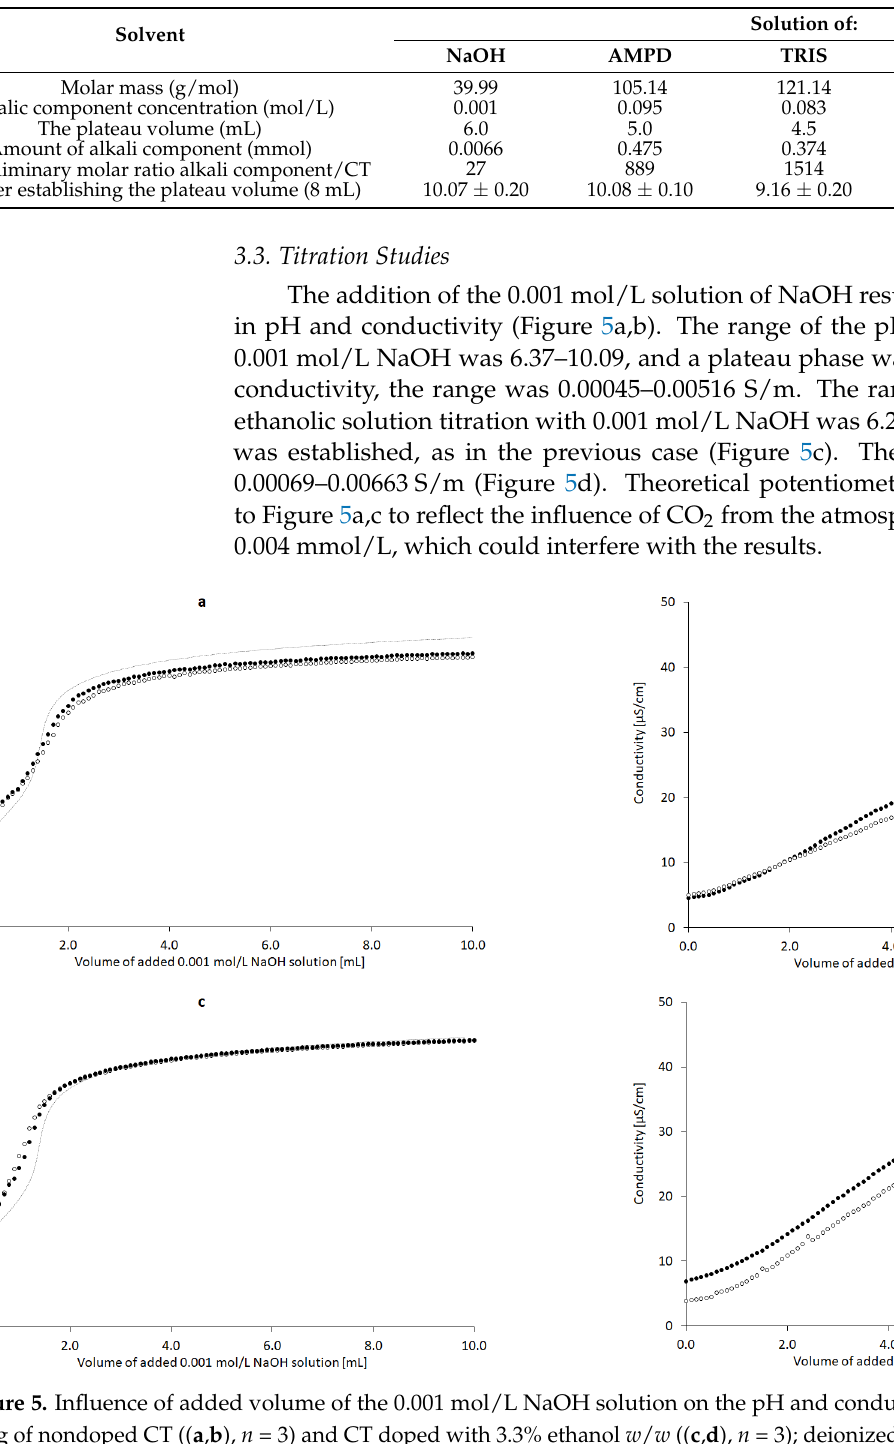
Table 3. Equations of standard plots for the evaluation of CT concentration in the HPLC assays.